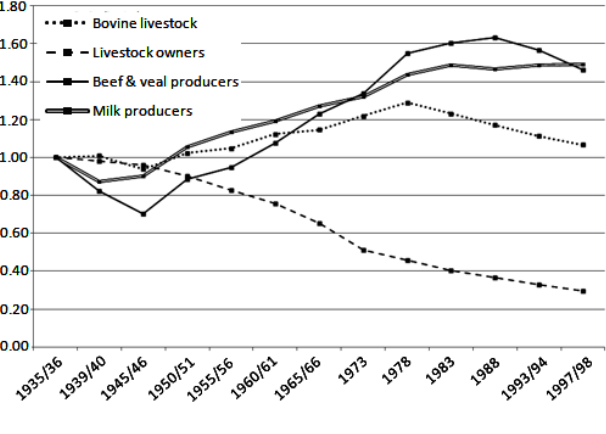
Fig. 1 . Evolution index of agricultural indicators in Switzerland between 1935 and 1998 (source: Swiss Federal Statistical